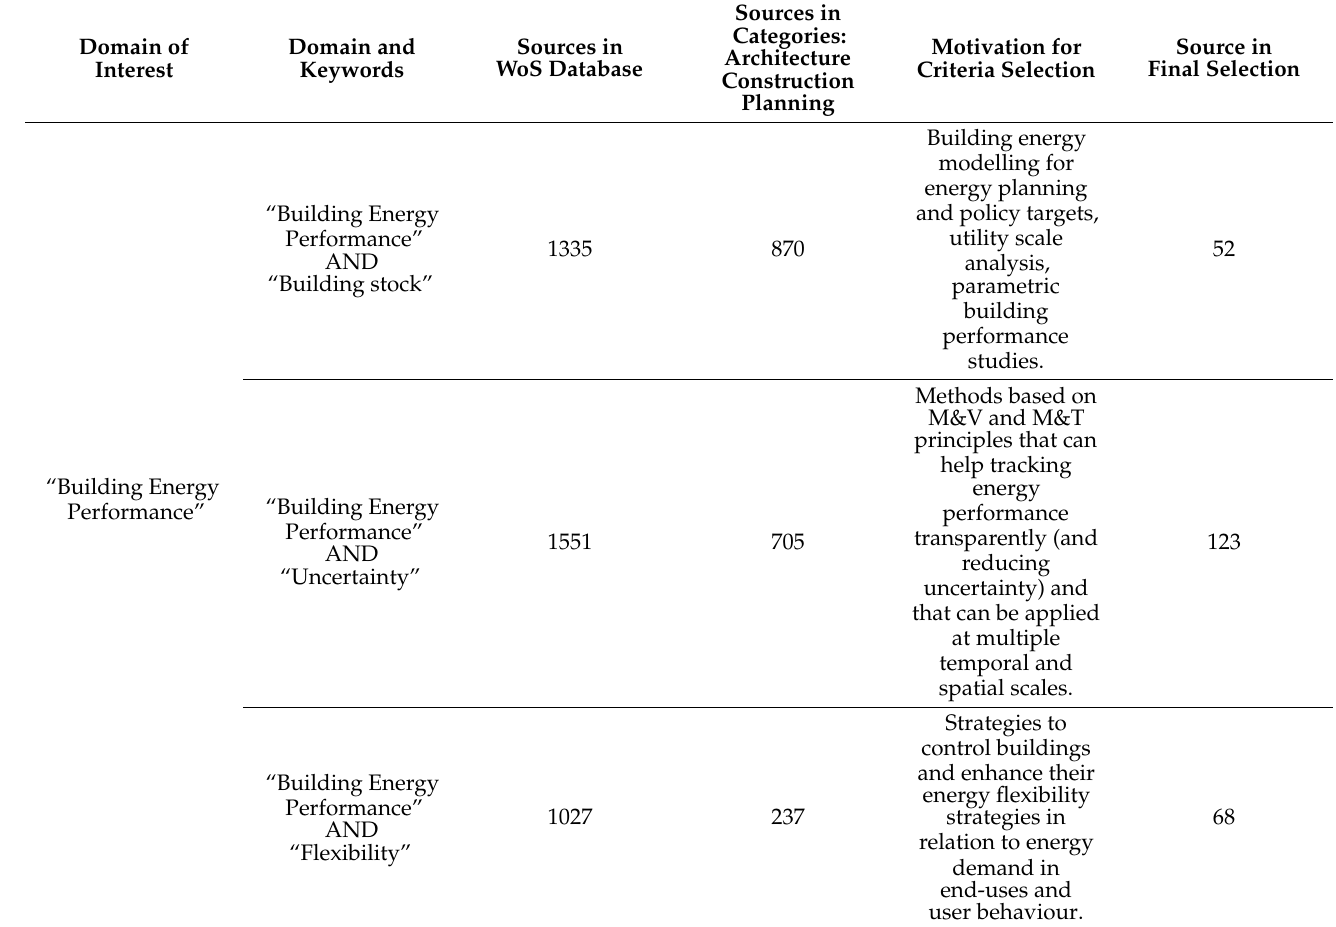
Table 1. Knowledge domain, keywords and criteria for literature